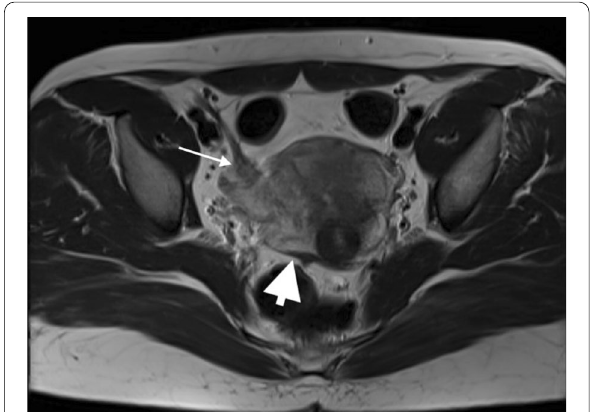
Fig. 2 T2 weighted axial MRI image showed involvement of right uterosacral (thick arrowhead) and round ligaments (thin arrow) by endometriosis showing as nodularities, irregularities, and